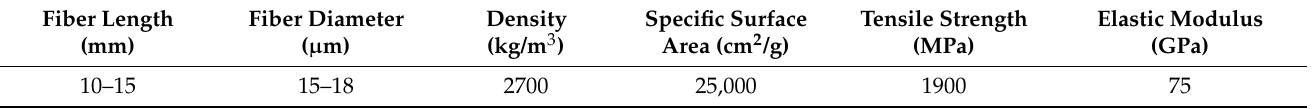
Table 3. Parameters of alkali-resistant glass